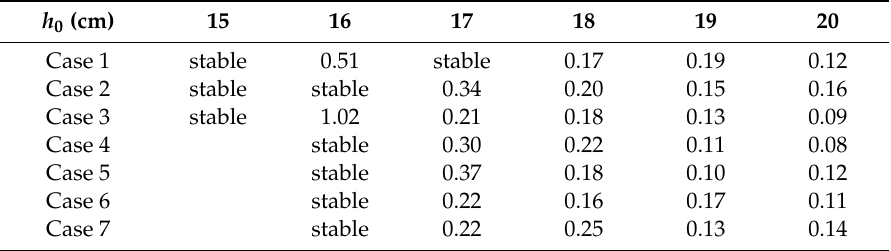
Table 1. Time interval (in seconds) between the flow arrival time and the time of block